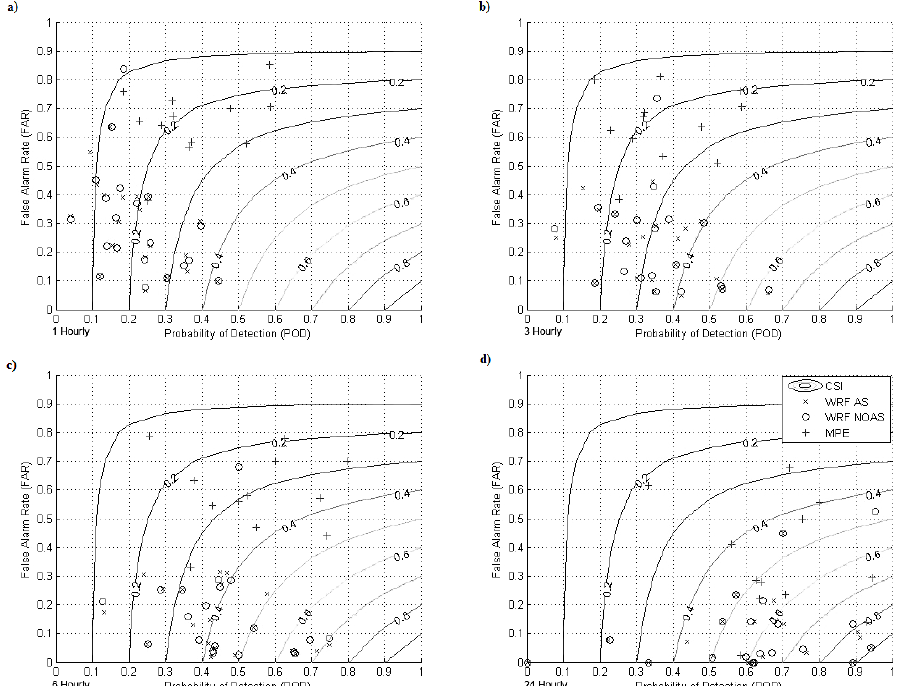
Fig. 8. POD, FAR and CSI statistics of WRF AS, WRF NOAS and MPE are shown together for each of the 25 events at 1, 3, 6, and 24h intervals in (a) , (b) , (c) , and (d) , respectively. Contours represent CSI values.